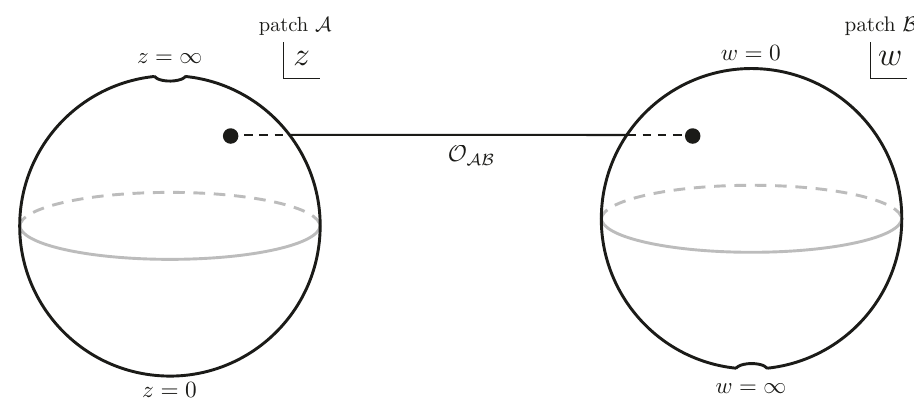
Figure 6 . Image of two patches covering north and south hemispheres transformation